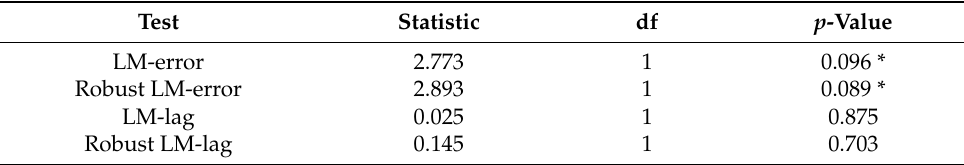
Table 3. Results of LM tests.